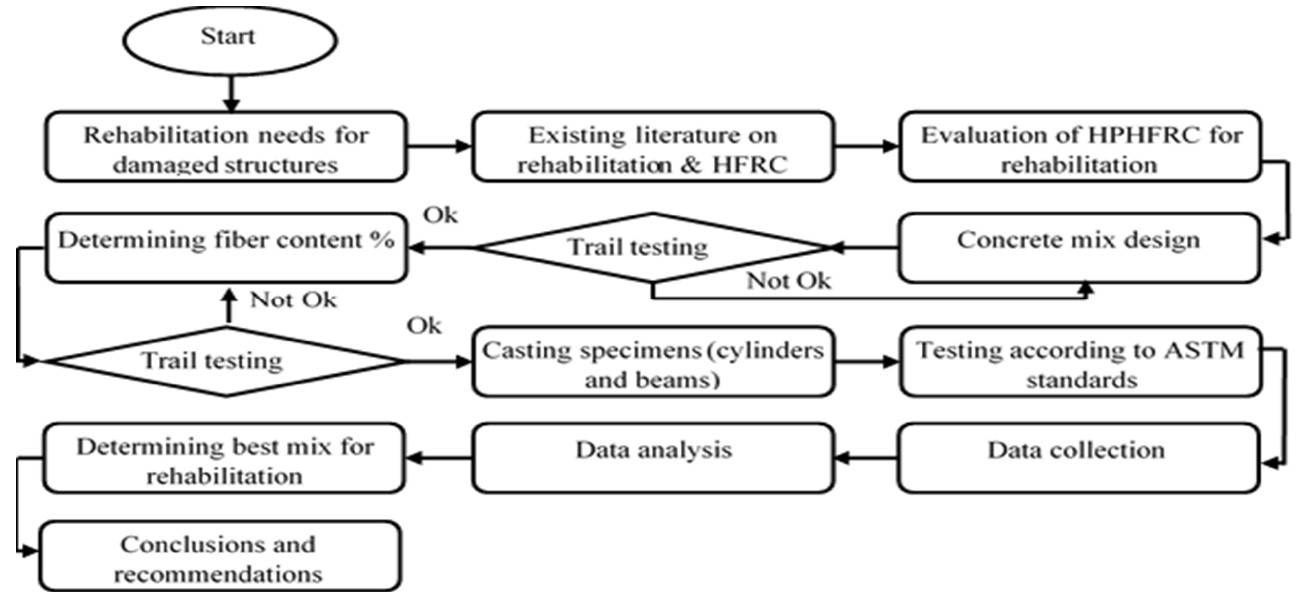
Figure 1. Methodology flow chart of the research work .